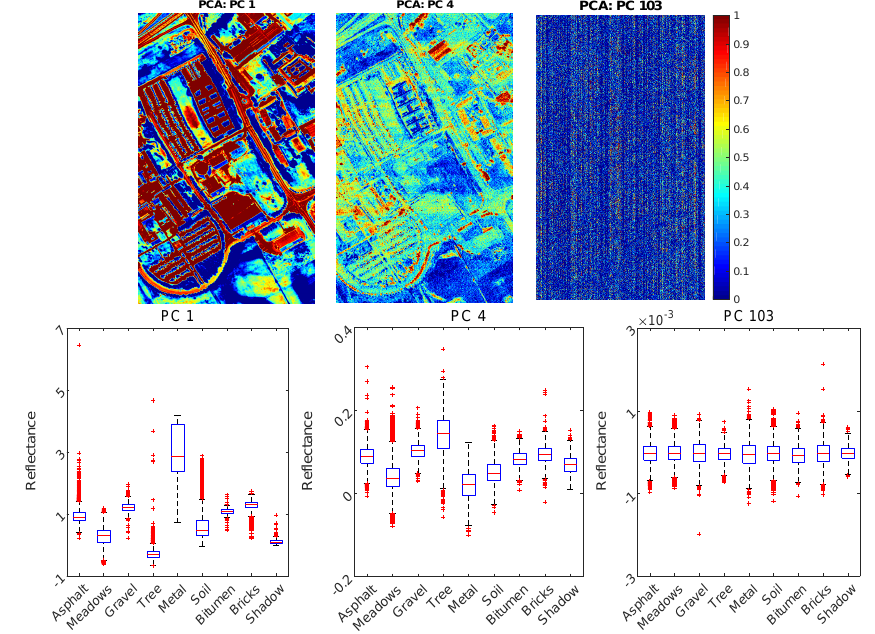
Figure 11. Sample PC bands (PC 1, PC 4 and PC 103) of linear PCA, and the corresponding box plot for the labelled data.